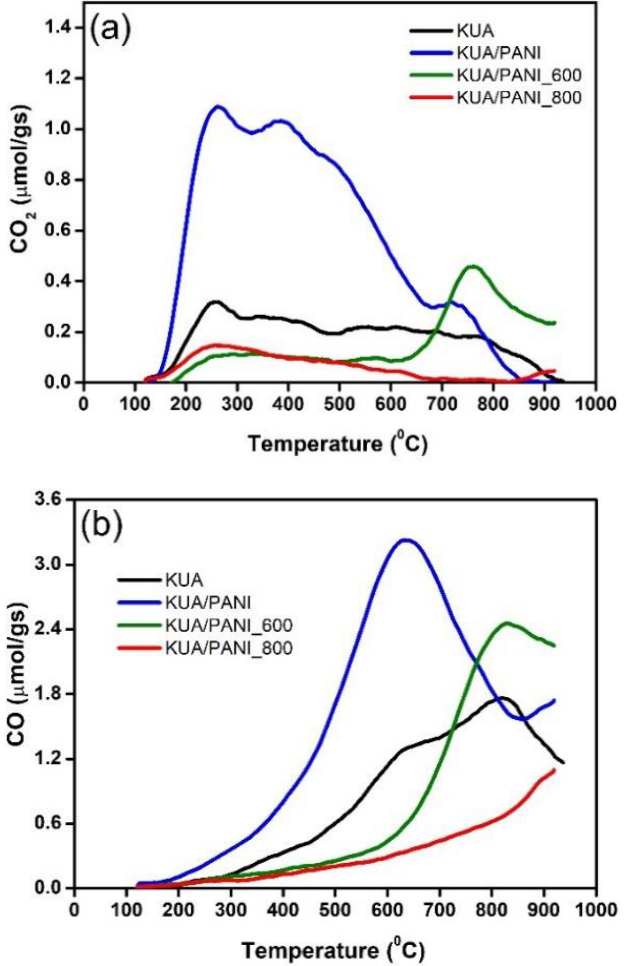
Figure 1. Comparison between ( a ) CO 2 and ( b ) CO TPD profiles of KUA, KUA/PANI, KUA/PANI_600 and KUA/PANI_800.